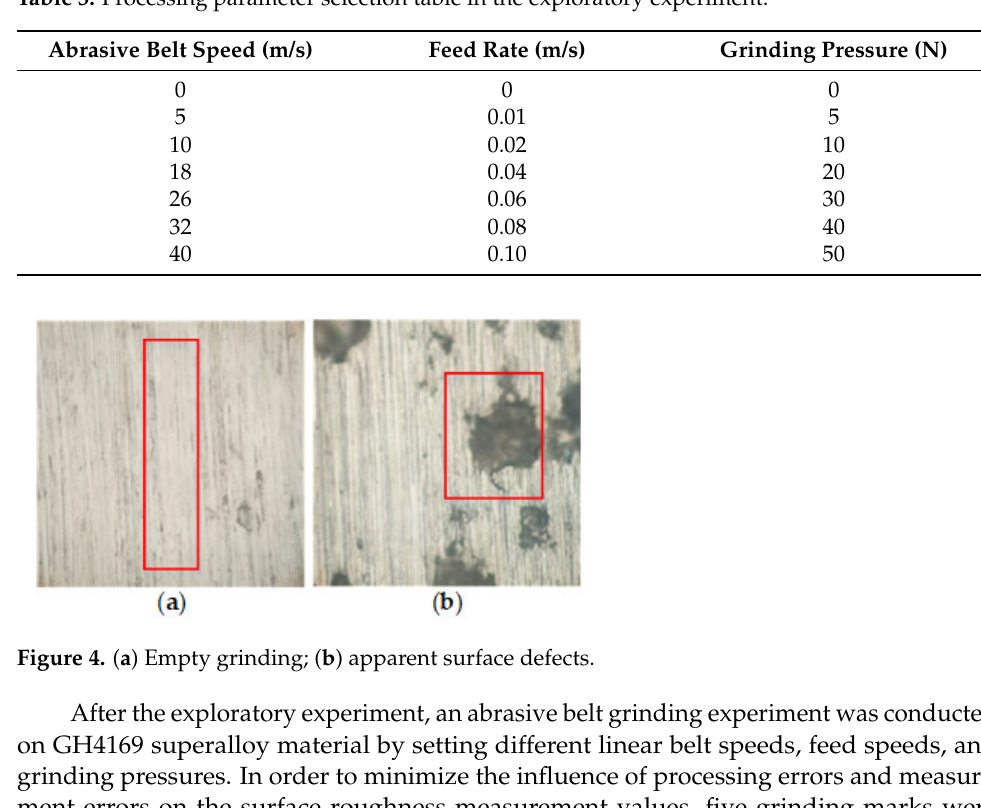
Table 4. Abrasive belt grinding experiment record table.